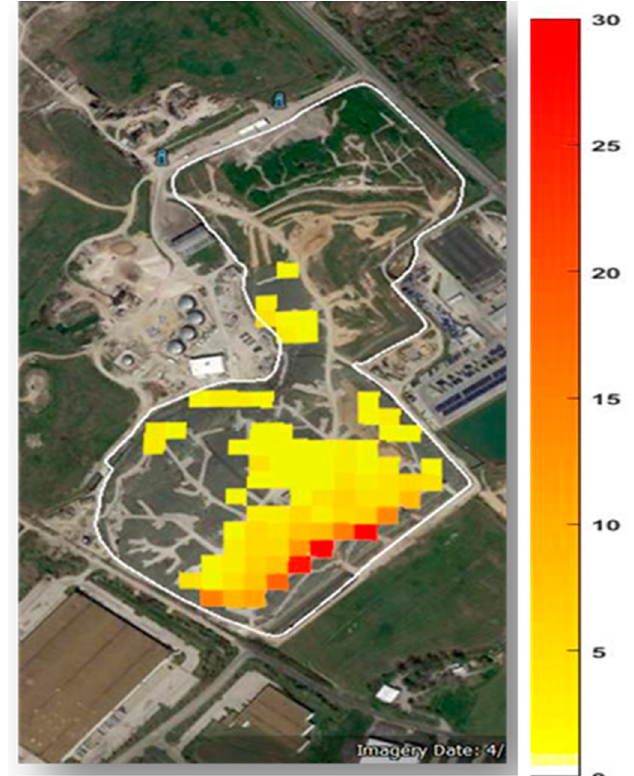
Figure 7. Location of frequency of maxima / near-maxima around the landfill site of Bridgeton, Missouri. The bar on the right side indicates the frequency of occurrence of maximum temperature at that point.